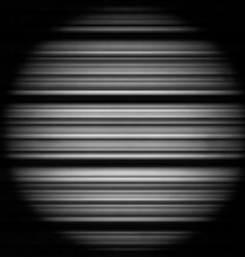
Figure 5. The extracted VLP-LED stripe